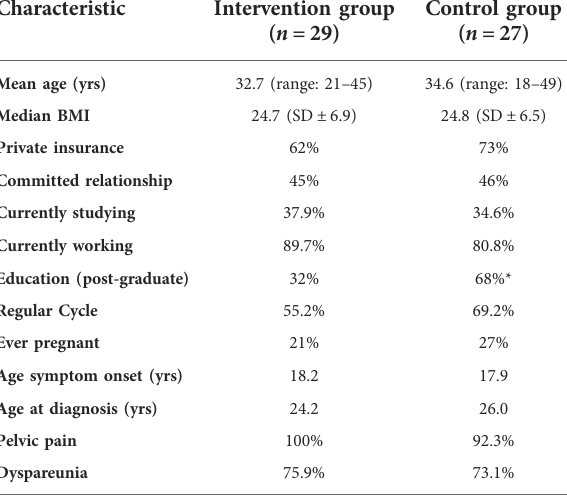
TABLE 2 Clinic-demographic characteristics of the study population.